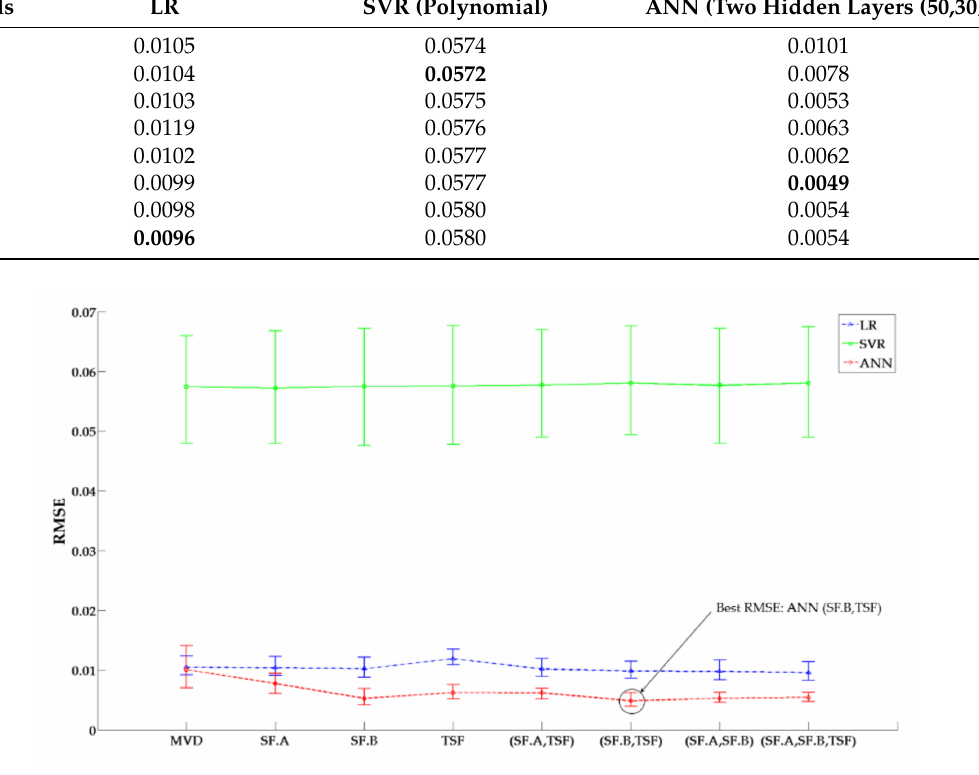
Figure 10. Comparison of SFC